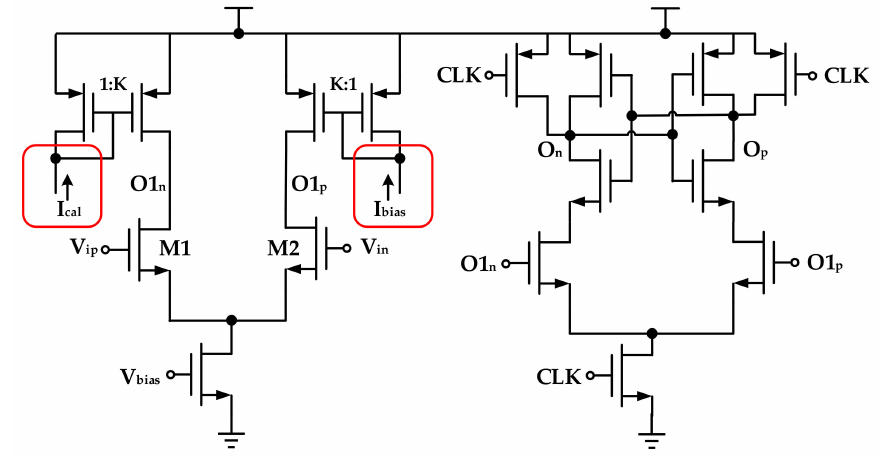
Figure 8. Schematic diagram of two-stage dynamic comparator.